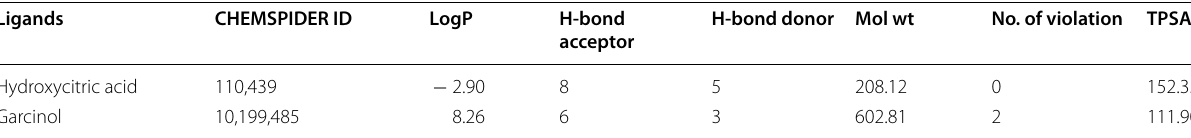
Table 2 Properties of ligands analyzed using